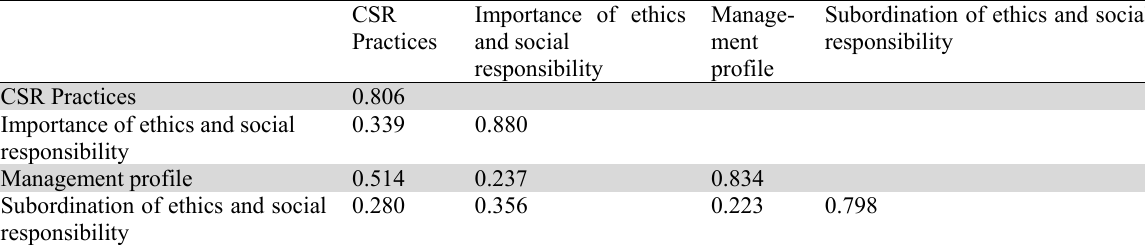
Discriminant Validity Fornell-Larcker Criterion